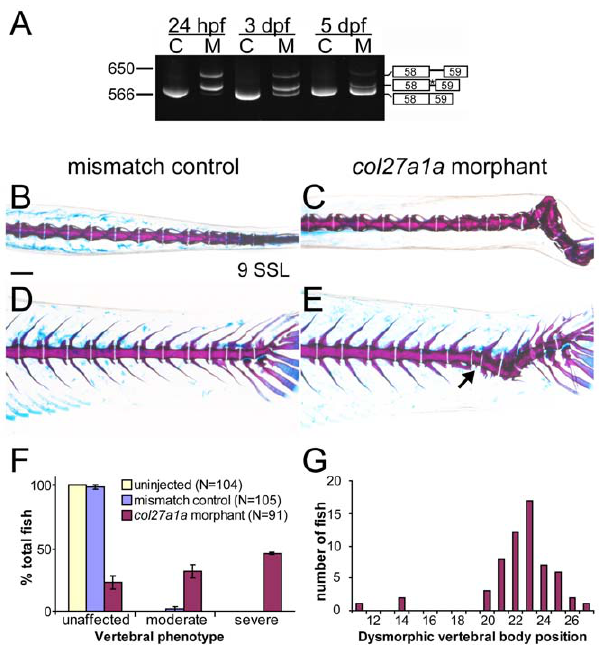
Figure 4. col27a1a morphants develop scoliosis and dysmor- phic vertebrae. (A) Embryos injected with a SBMO targeting the exon 58 splice donor site of col27a1a showed abnormal splicing. Two abnormal splice forms including portions of intron 58 were generated. One splice form was predicted to generate a premature stop codon (asterisk). C, control; M, morphant. Dorsal and lateral views of col27a1a morphants (C, E) and mismatch control siblings (B, D) at , 8.1–9.0 SSL (21 dpf) showed formation of scoliotic curves in the morphant vertebral column. Morphants were injected with a combined dose of 5 ng col27a1a SBMO + 1 ng col27a1a TBMO. (F) By , 8.1–9.0 SSL, 78% of